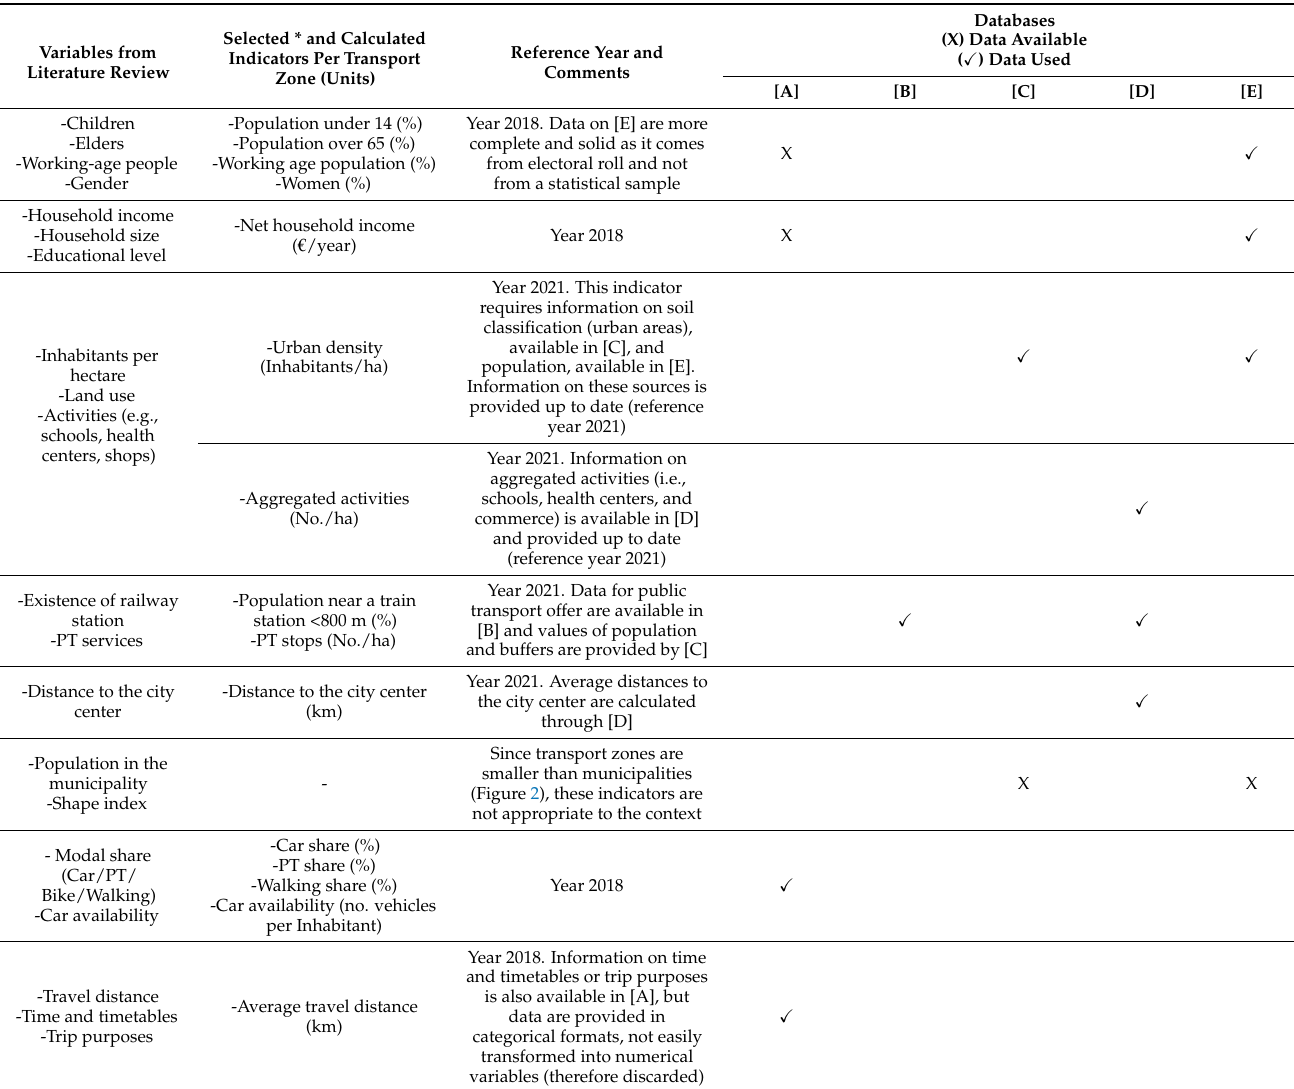
Table 3. Indicators and